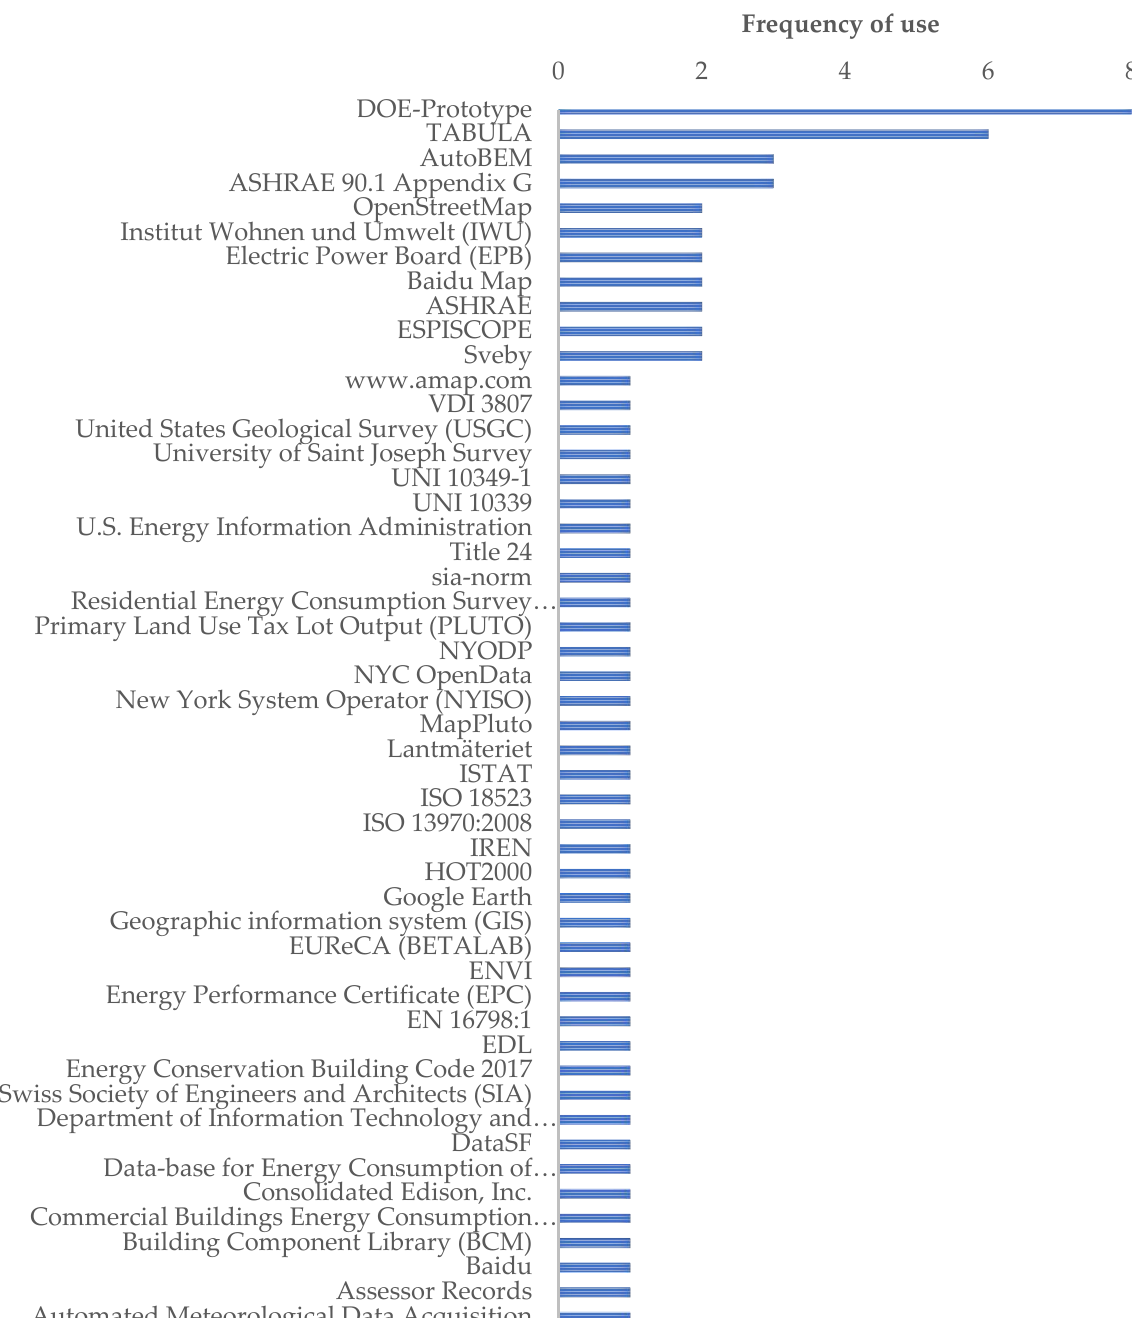
Figure 16. Frequency of data sources for urban building energy modeling development, including the measured data and synthetic prototype data.